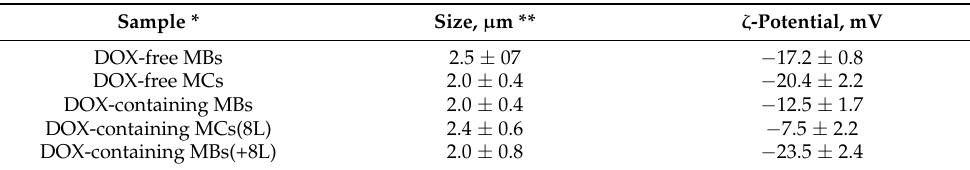
Figure 1. Microphotographs of typical doxorubicin-free and doxorubicin-containing calcium carbon- ate microbeads obtained by optical ( a , c ) and scanning electron ( b , d ) microscopies, respectively. The size distribution histograms of both particle types are presented in the insets ( a , c ). Table 1. Disperse characteristics of doxorubicin-free and doxorubicin-containing microbeads and microcapsules with different